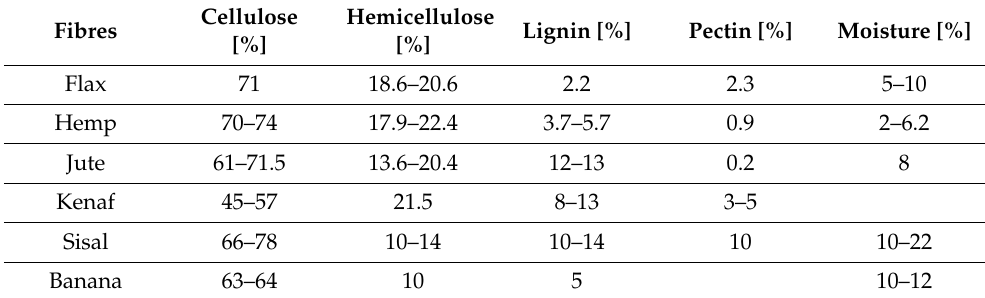
Table 1. The chemical composition and moisture content in the selected popular plant